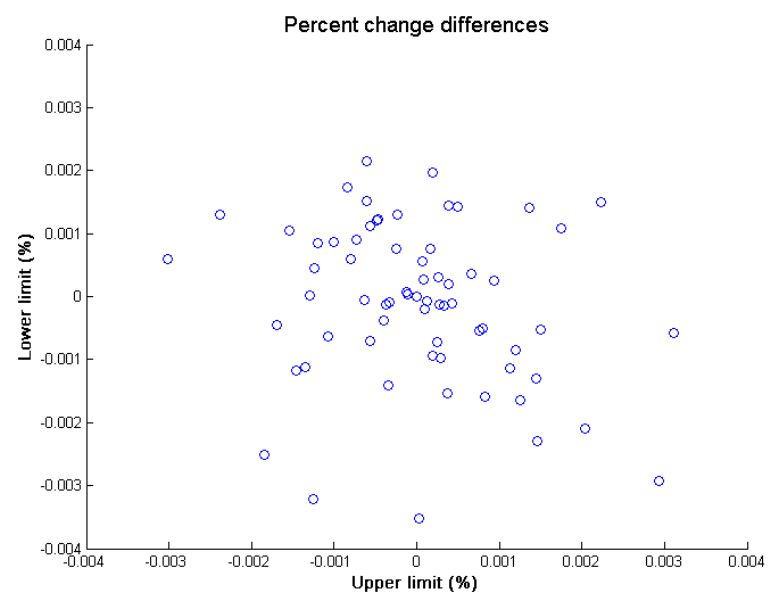
Figure 4. Comparison of percent change of upper and lower uncertainty bands resulting from the inclusion of an instrumental error.